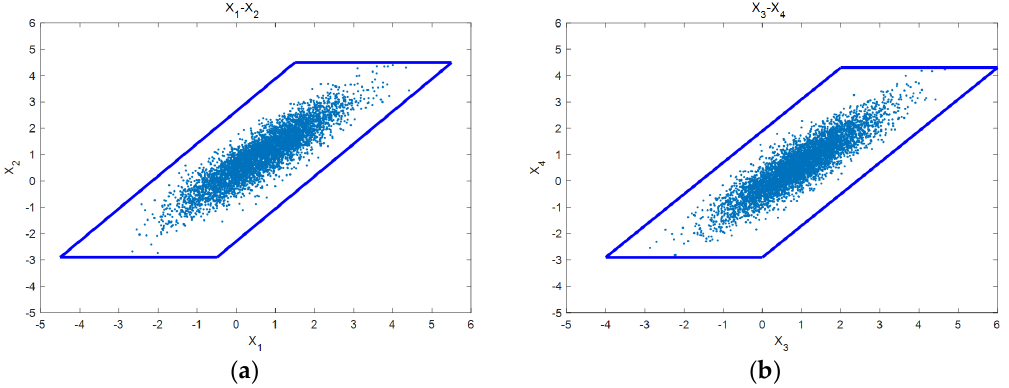
Figure 8. Construct the parallelogram model of the X1−X2 plane and the X3−X4 plane. ( a ) X1 − X2 plane; ( b ) X3 − X4 plane. plane; ( b ) X3 − X4